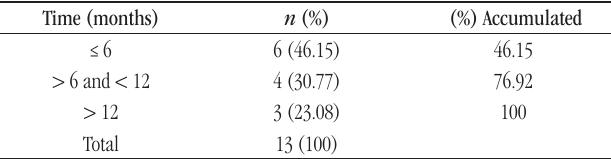
taBLE 2 − Time between transplantation and the first UC with the presence of koilocytes